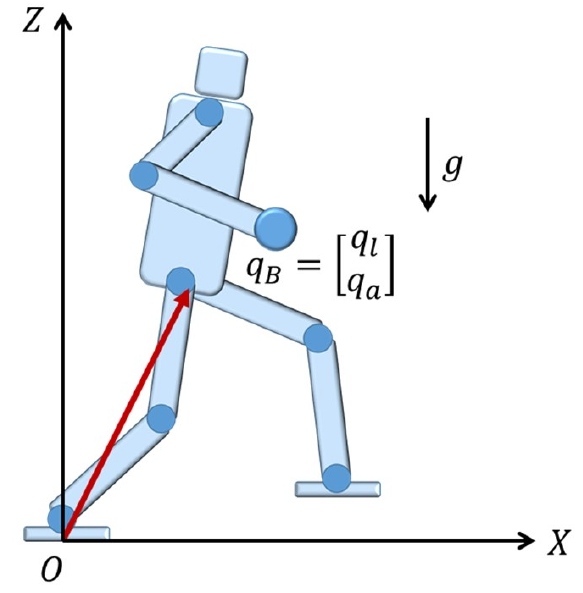
Figure 4. The floating base